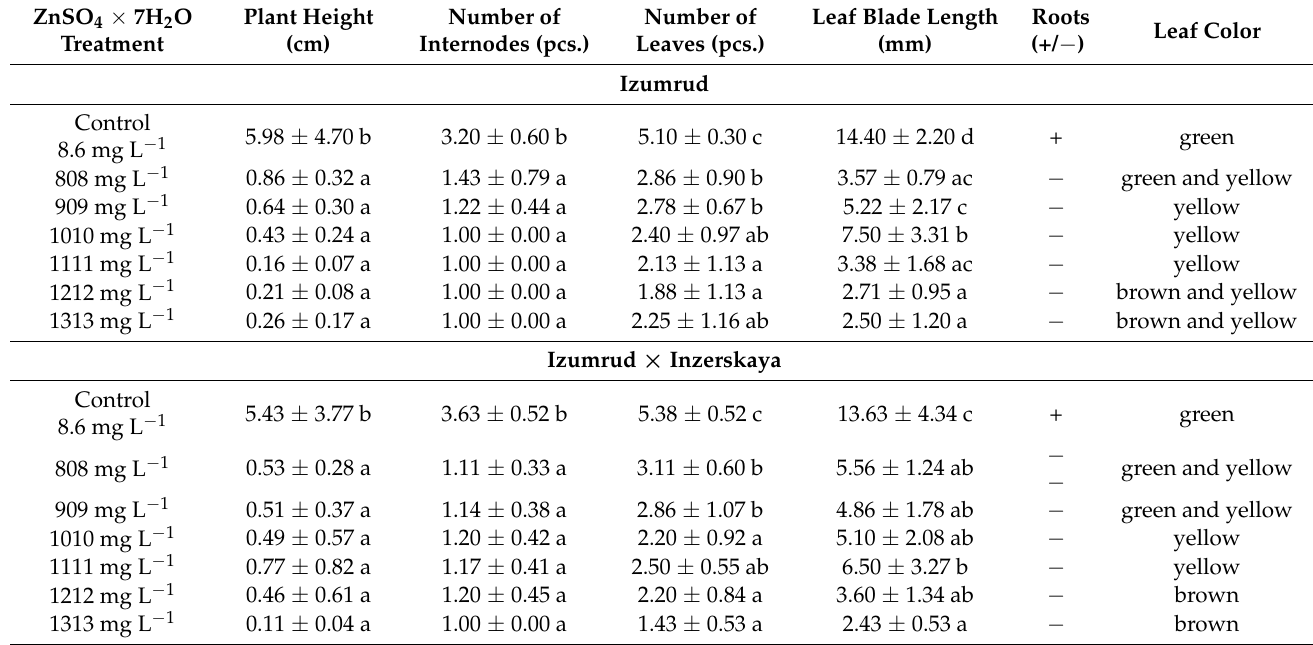
Table 1. Effect of selective media with ZnSO 4 × 7H 2 O on morphological indicators of buckwheat regenerants at 21 days of